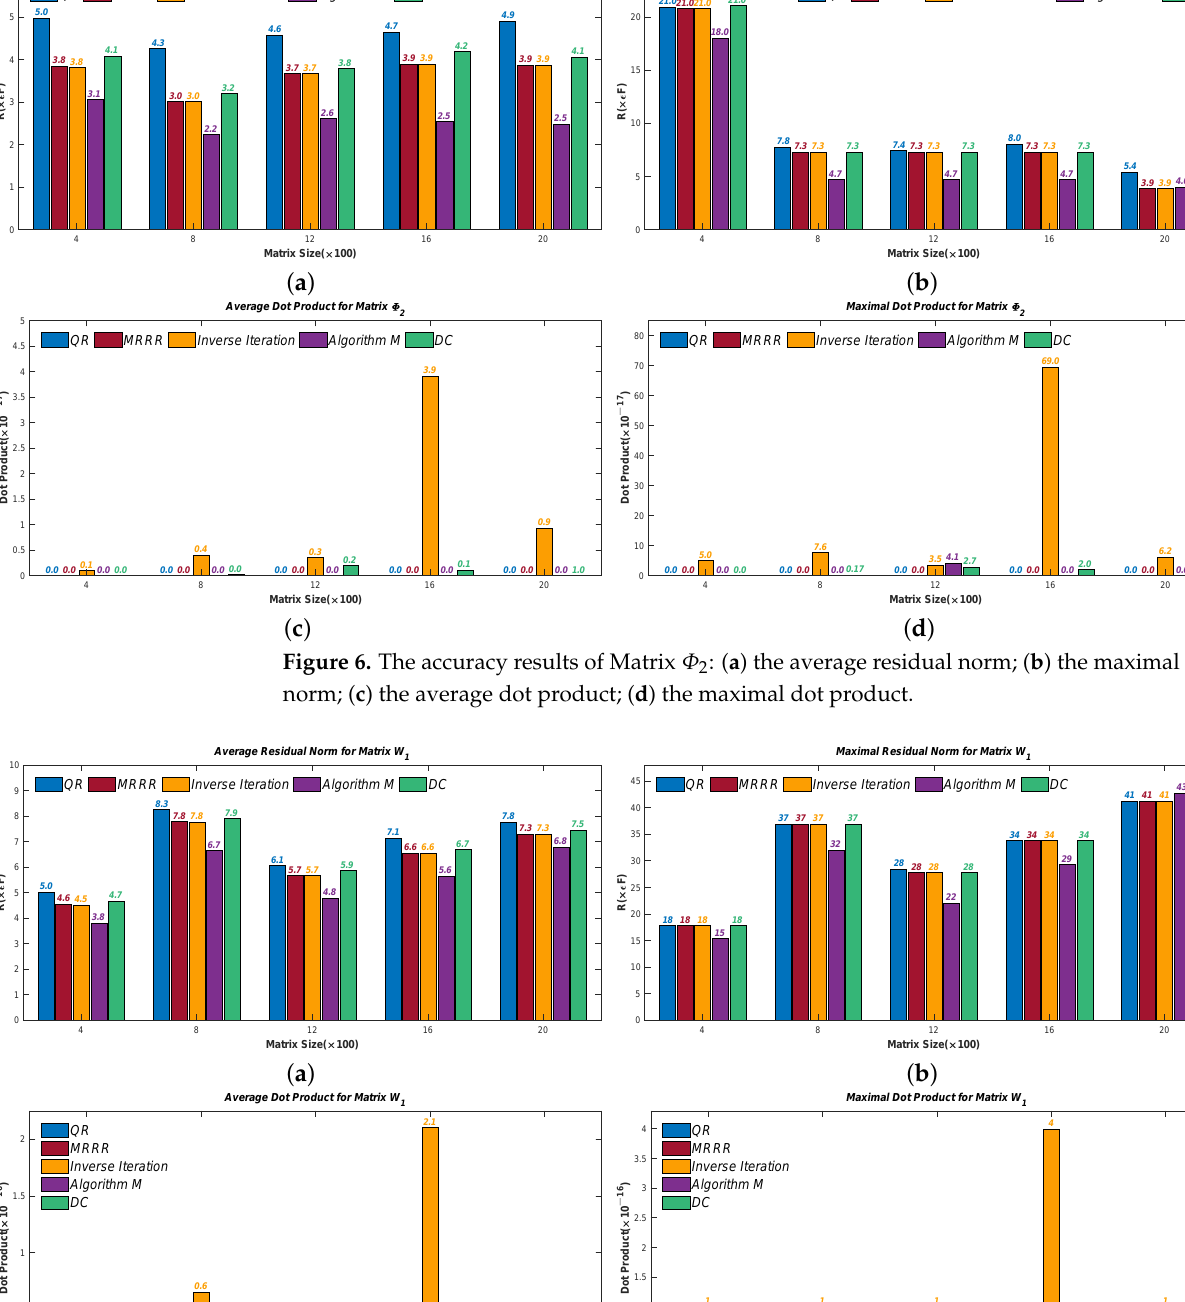
Average Dot Product for Matrix W 1